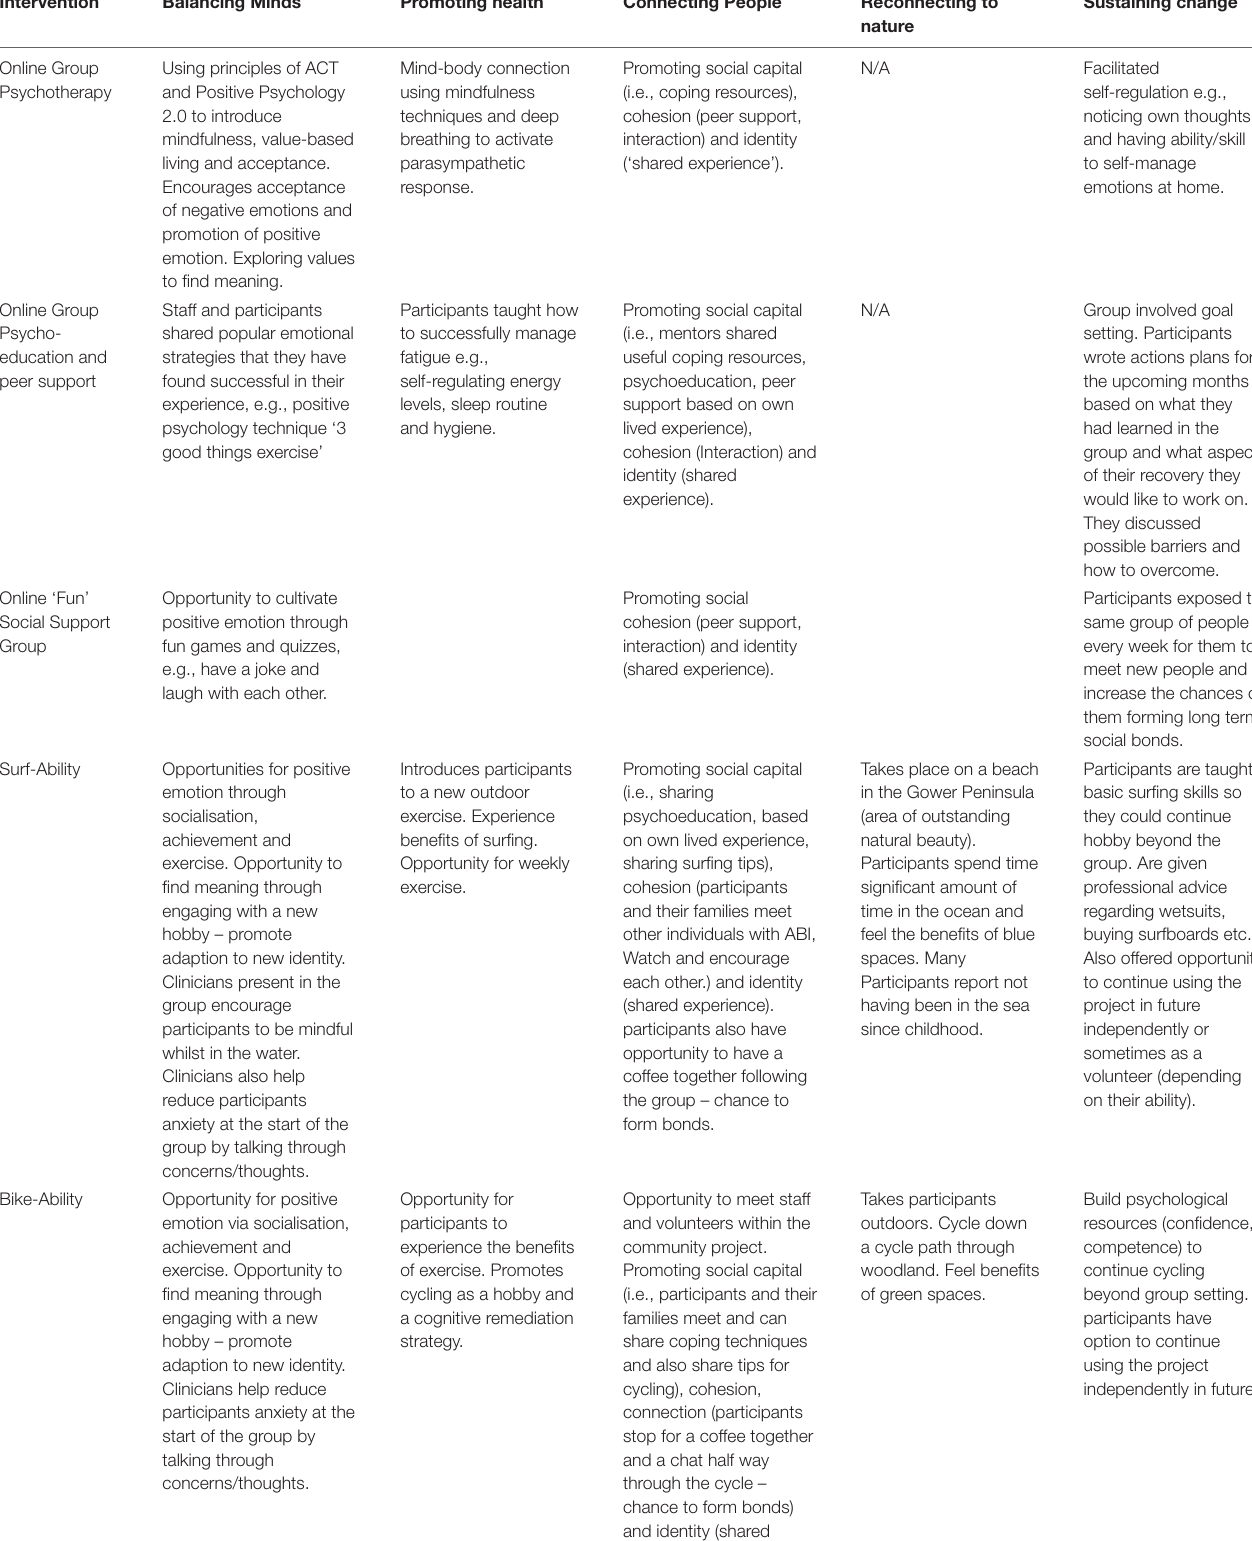
TABLE 1 | Link between interventions and previously identified predictors of